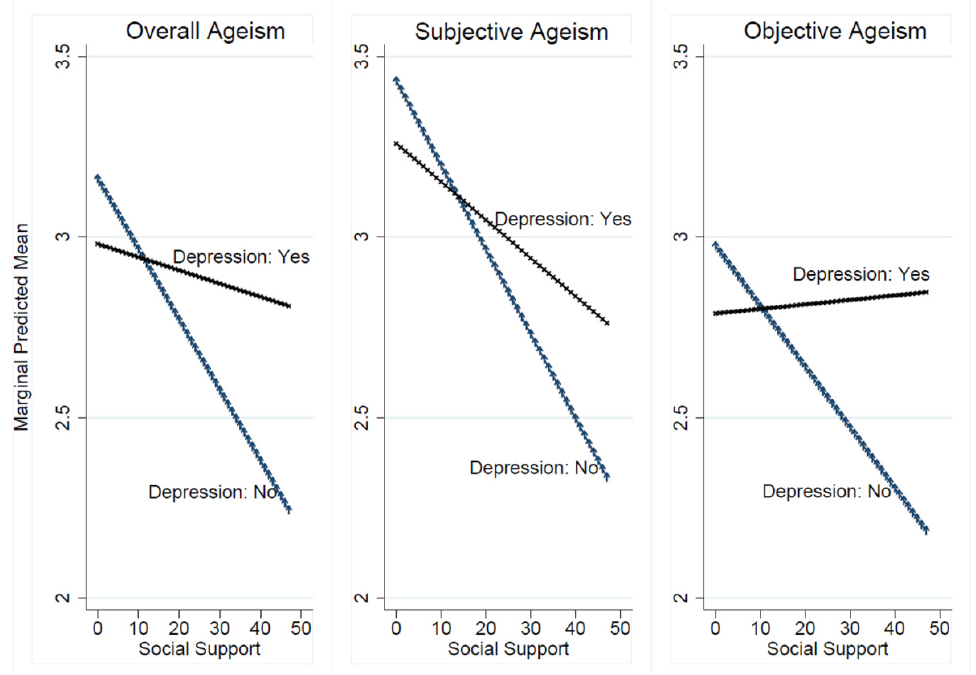
Figure 2. Relationship between depressive symptoms and ageism, the modifying role of social sup- port.